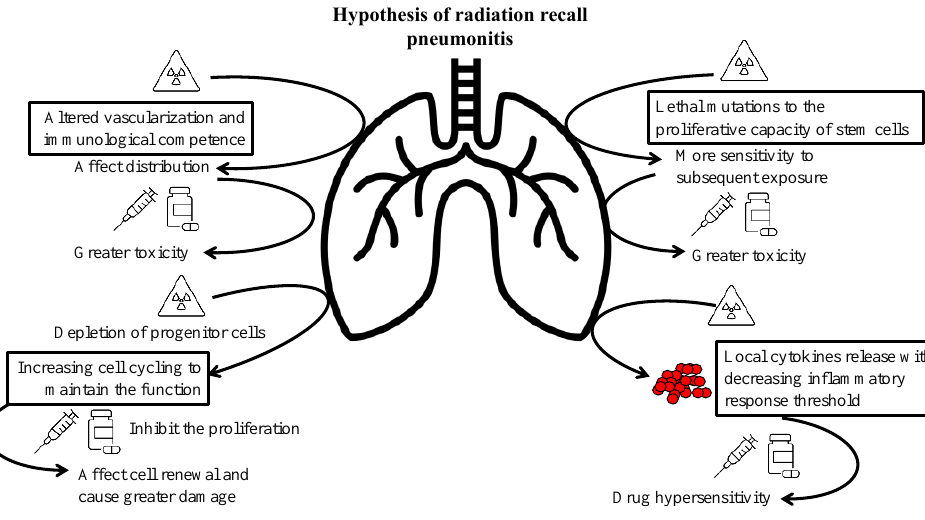
Figure 2. Summary of possible hypotheses of radiation recall pneumonitis.